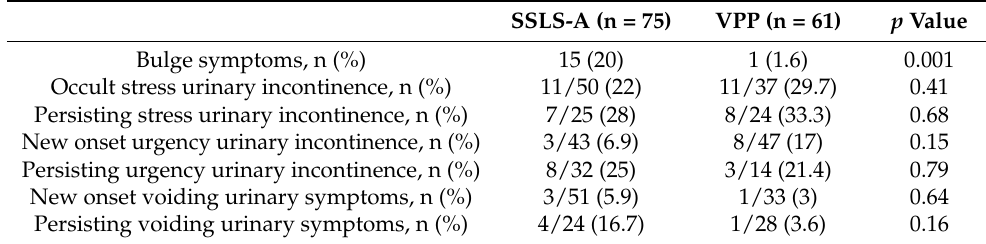
Table 7. Pelvic floor dysfunction symptoms of the study population at follow